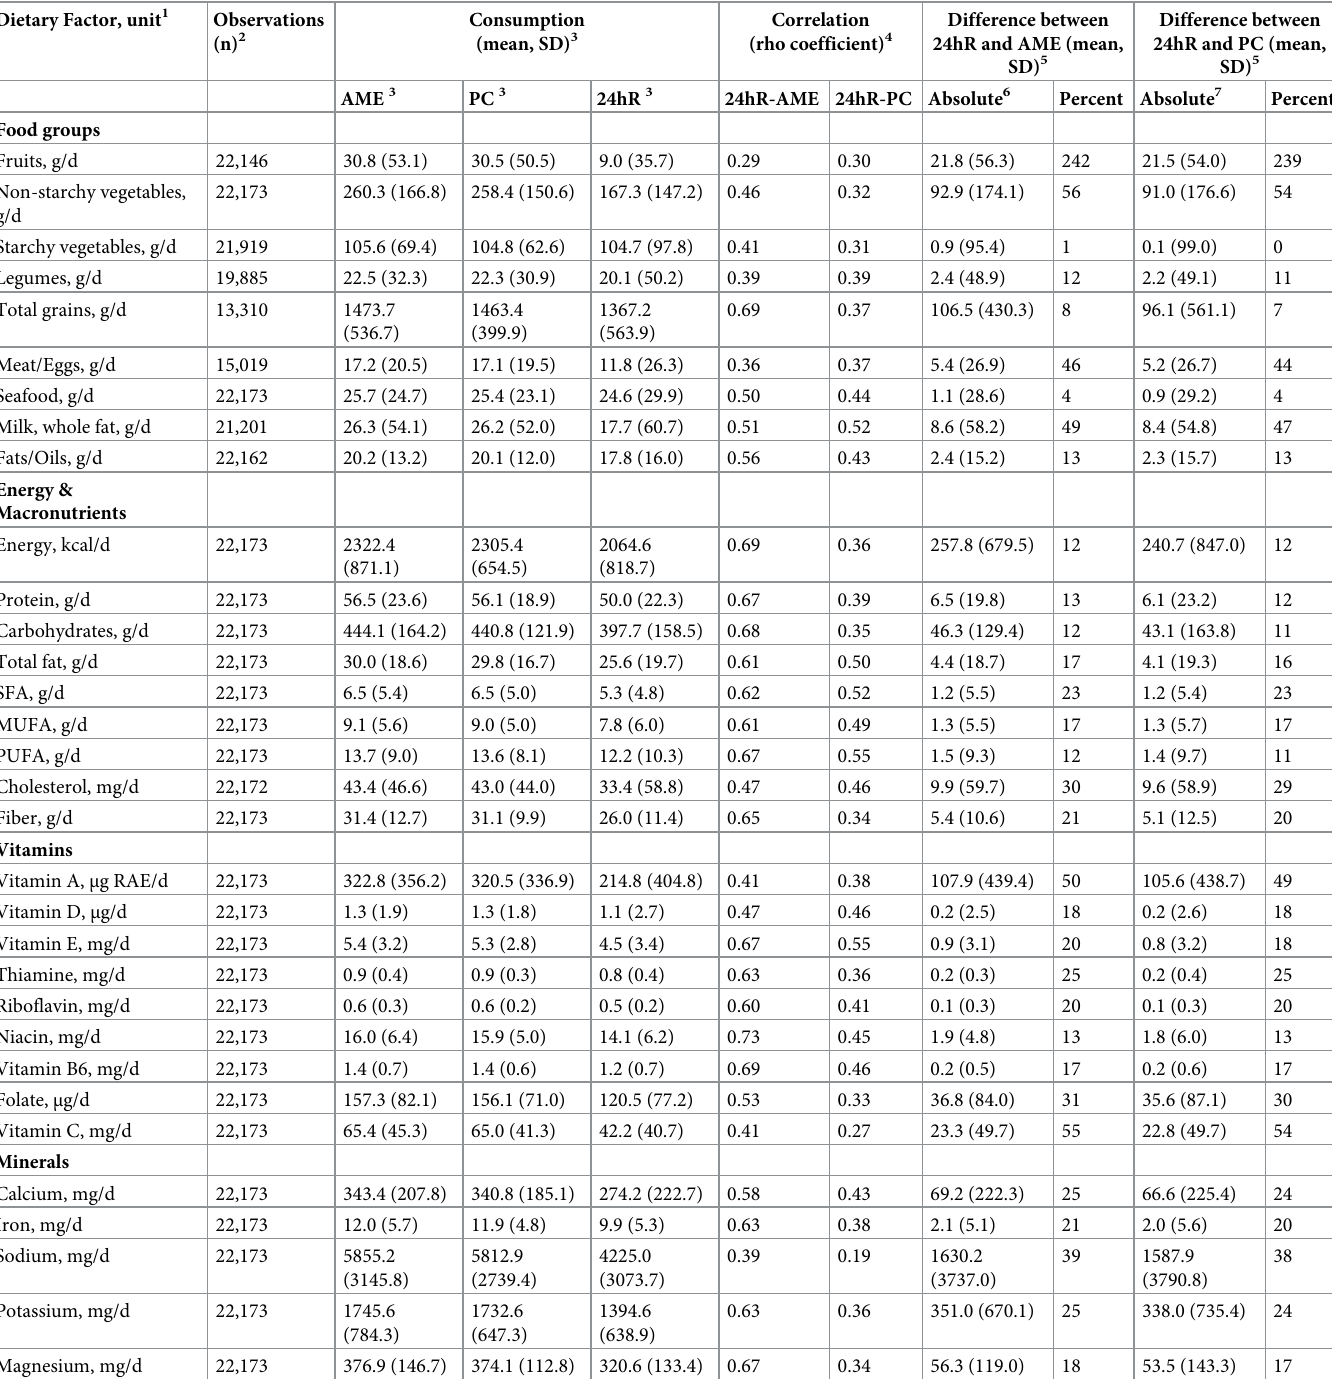
Table 2. Comparison of individualized household consumption and individual dietary estimates by dietary factor in the 2011–2012 BIHS. Dietary Factor, unit